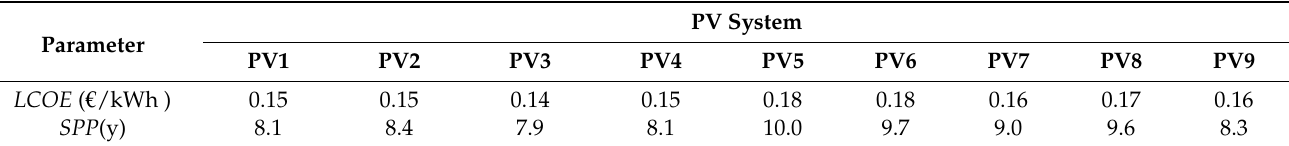
Table 5. Financial assessment of the analyzed